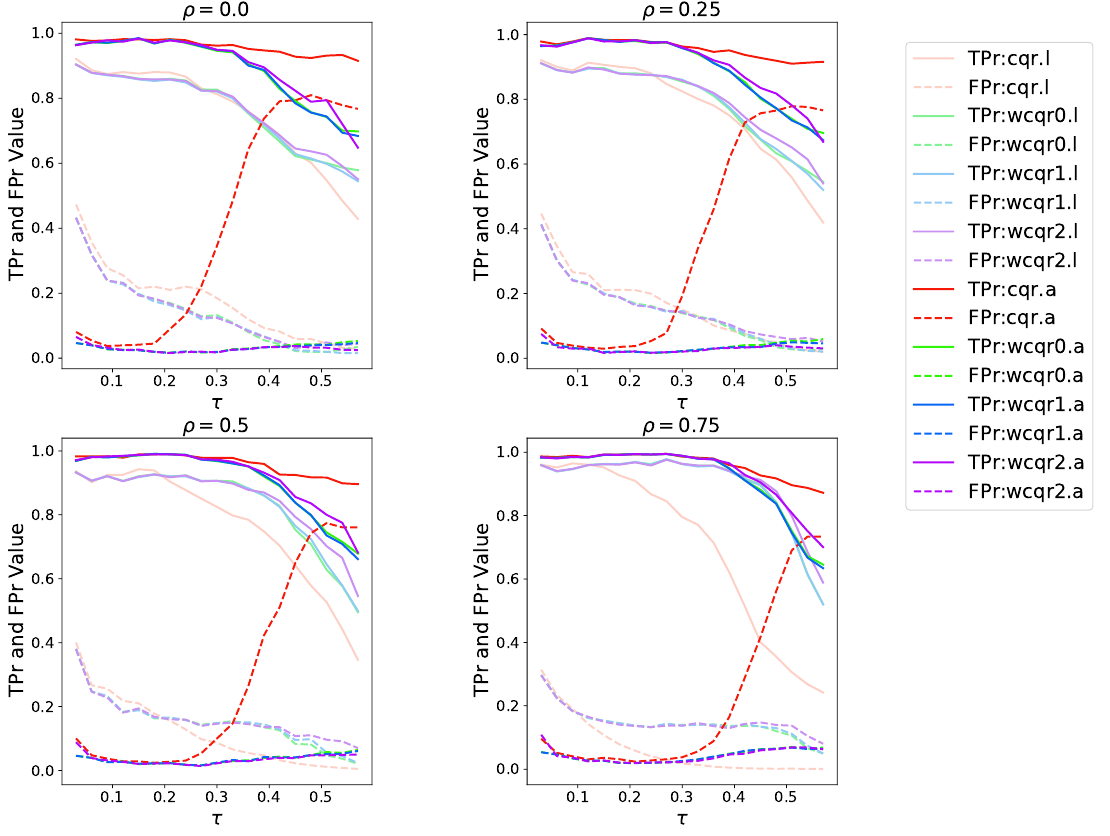
Figure 1. Case n = 200, s = 30, p 0 = 0.8, p 1 = 0.6. Comparison of TPr and FPr for four levels of ρ . In each subplot, the Y axis reports the TPr and FPr values at different τ . The solid line is TPr and the dashed line is FPr. Four colors are used to represent the methods: red for wcqr, green for wcqr0, blue for wcqr1, and purple for wcqr2. Light colors represent the LASSO penalty and dark colors are the ALASSO penalty for all